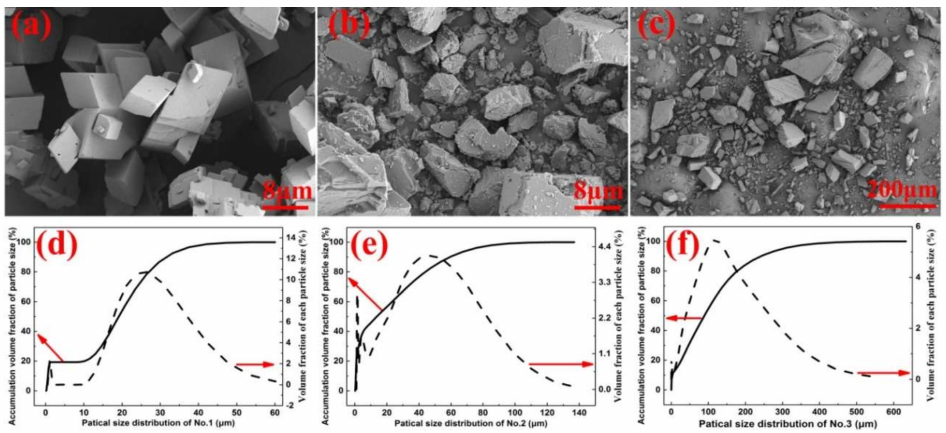
Figure 1. ( a ) SEM of analytically pure calcium carbonate (No.1); ( b ) SEM of calcite crystal power (No.2); ( c ) SEM of calcite power (No.3); ( d – f ) Particle size distribution and accumulation volume fraction of the particle size for No.1, 2 and 3.